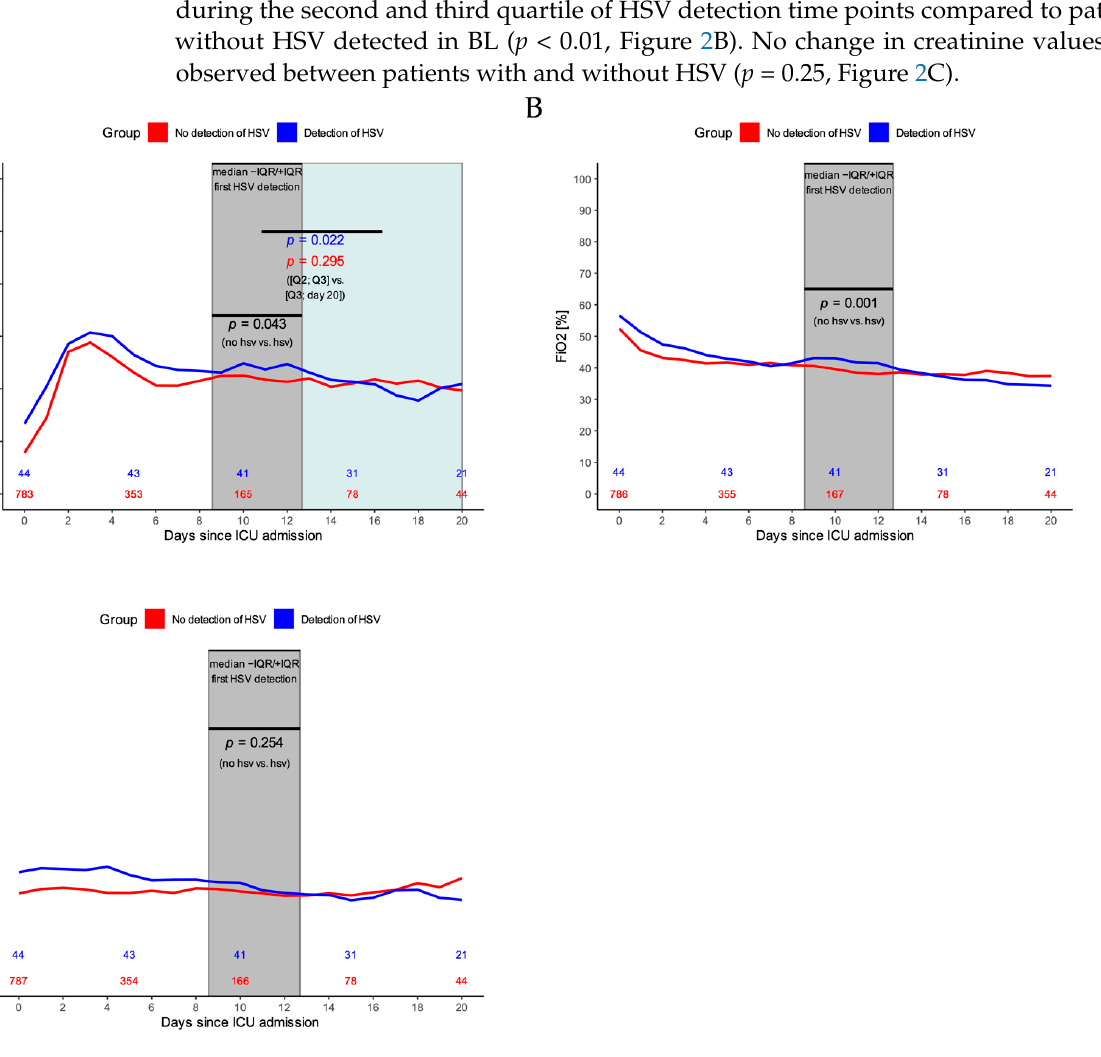
Figure 2. ( A ) CRP dynamics during ICU stay for patients with (blue line) and patients without HSV detection (red line). p -value in black indicates the statistical difference for CRP values of patients with vs. without HSV during the second and third quartile of HSV detection timepoints (grey area). p -values in color indicate the statistical difference for CRP values of patients with (blue line) and without HSV (red line) during the second and third quartile of first HSV detection values vs. the time after that until day 20. ( B ) Fraction of inspired oxygen (FiO2) for patients with (blue line) and without HSV detection (red line). p -value indicates the statistical difference for FiO2 values of pa- tients with vs. without HSV during the second and third quartile of HSV detection timepoints (grey area). ( C ) Creatinine values for patients with (blue line) and without HSV detection (red line). p - value indicates the statistical difference for creatinine values of patients with vs. without HSV dur- ing the second and third quartile of HSV detection timepoints (grey area). 3.5. Risk Factors for HSV Occurrence A binary regression model was developed to investigate which factors could favor the occurrence and, therefore, detection of HSV in patients with mechanical ventilation for at least seven days and BL. The results of univariate analysis are shown in Table 4. After stepwise selection of parameters, cardiovascular risk factor arterial hypertension (HR 3.240, p = 0.034), bilirubin measured on ICU admission (HR 2.125 per mg/dL, p <